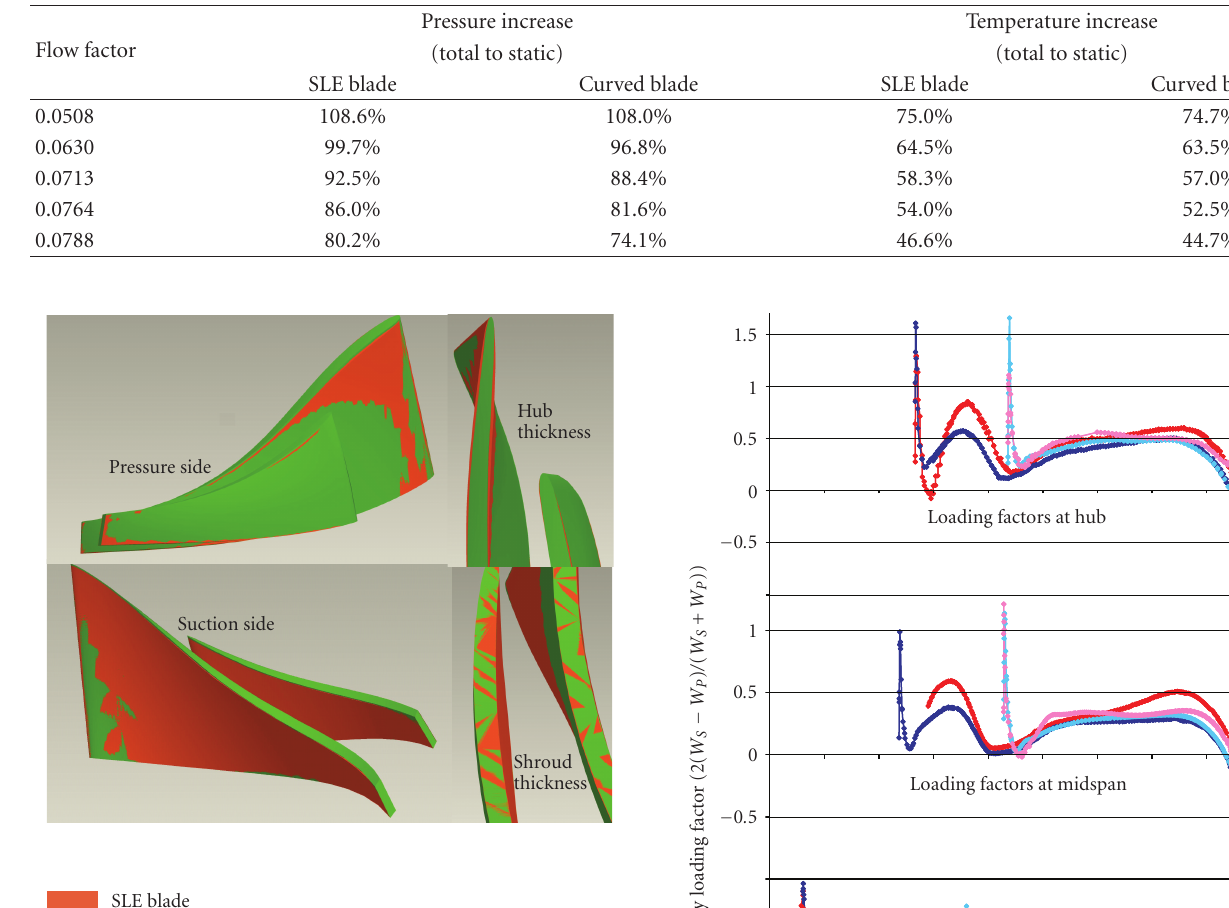
Table 2: Comparative properties of SLE and curved blades analyses.